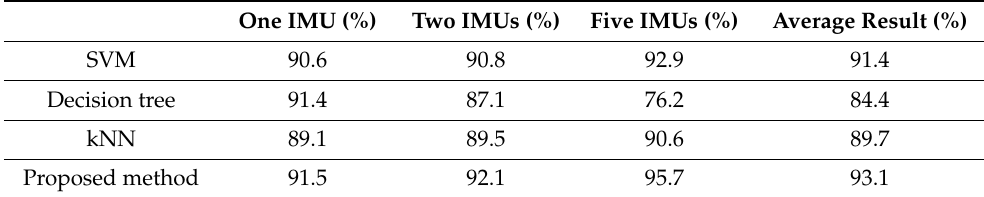
Table 2. The accuracy of different methods on the different amount of IMUs.